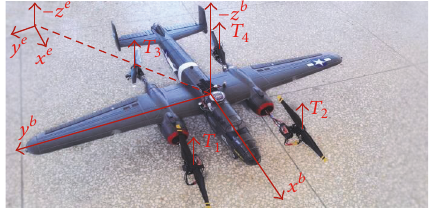
Figure 1: Coordinate systems: inertial earth fixed frame and body fixed